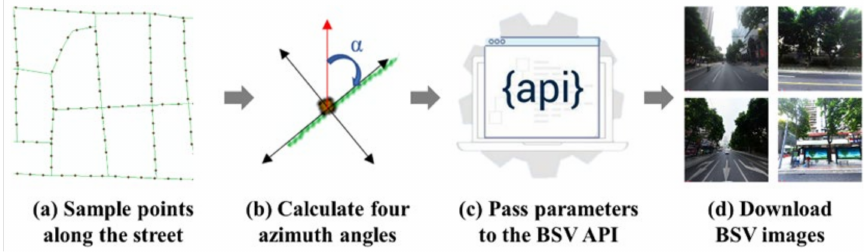
Figure 2. Steps of downloading BSV